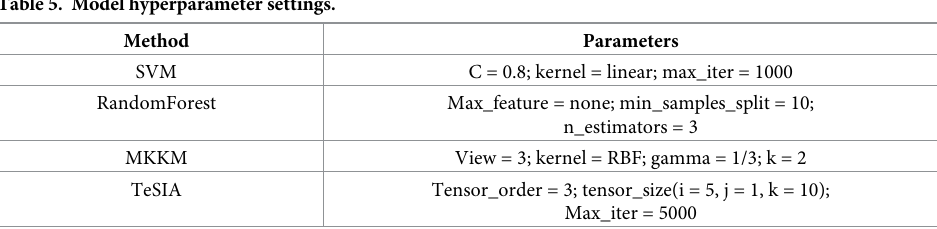
Table 5. Model hyperparameter